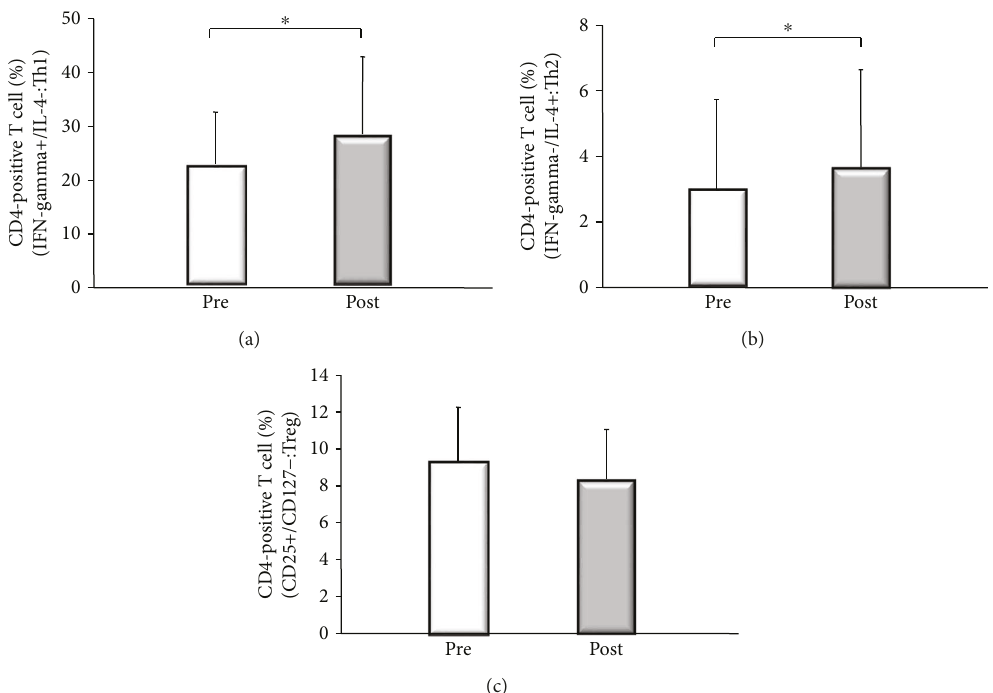
Figure 6: Peripheral blood Th1, Th2, and Treg cells before and 4 weeks after partial splenic embolization (PSE). Upper left: IFN- γ -positive/ IL-4-negative cells (Th1 cells) showed a signi fi cant increased after PSE compared to before PSE (from 22.5 ± 9% to 27.7 ± 12%: ∗ p = 0 0027 , by Wilcoxon ’ s test). Upper right: IFN- γ -negative/IL-4-positive cells (Th2 cells) also increased signi fi cantly after PSE (from 3.2 ± 3% to 3.8 ± 3%: ∗ p = 0 0202 , by Wilcoxon ’ s test). Lower: there was no signi fi cant change of regulatory T cells (Treg cells), which were identi fi ed as CD25 high / CD127 low cells, between before and after PSE (from 9.2 ± 3% to 8.1 ±